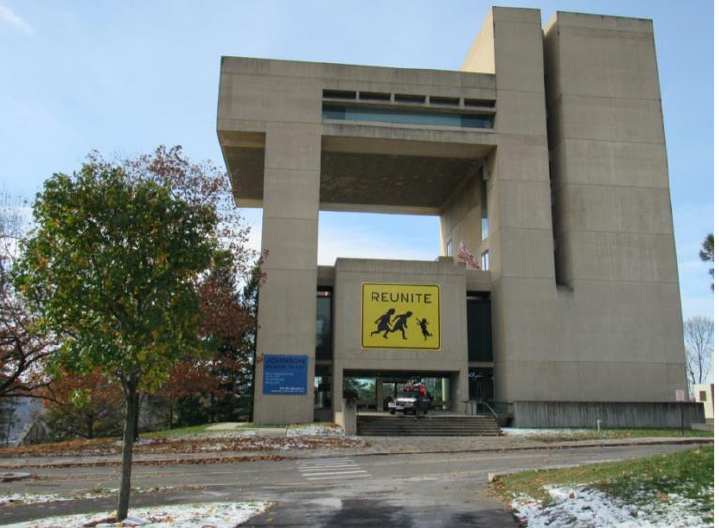
Figure 1 Herbert F. Johnson Museum of Art, Cornell University. November 2019. Installation view of four artworks in the exhibition how the light gets in . Lucy + Jorge Orta, Antartica Flag – La Villete ,